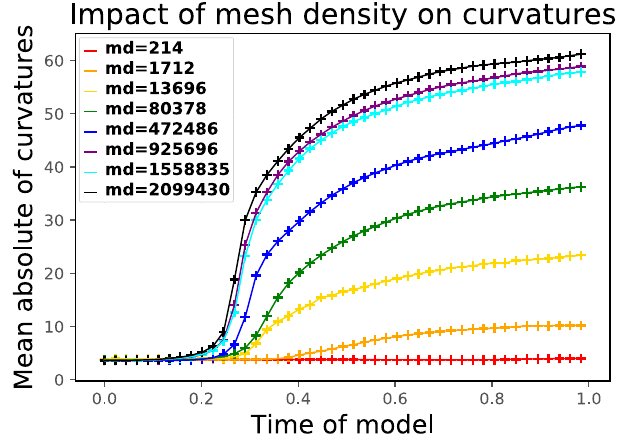
Figure 11. The comparison of average of absolute value of dimensionless mean curvatures for simulated surfaces of different mesh densities (md).